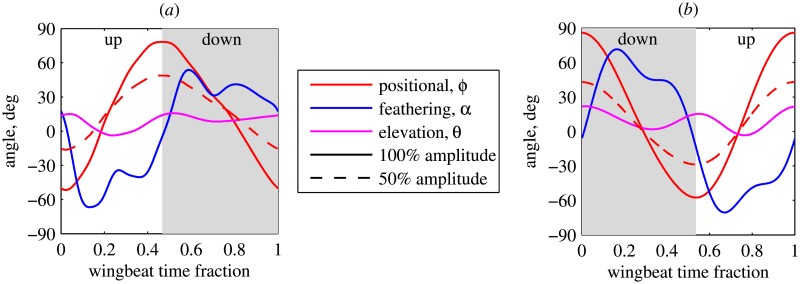
Periodic wing kinematics.(a) Data obtained by periodization of the last wingbeat shown in [15]. It is used in section Takeoffs with simplified kinematics. Also, in section Ground effect in hovering flight, this kinematics is referred to as ‘P1’ (‘P’ for ‘Periodic’). The cycle begins from the upstroke. (b) Data adapted from [6]. In section Ground effect in hovering flight, it is referred to as ‘P2’. The cycle begins from the downstroke.